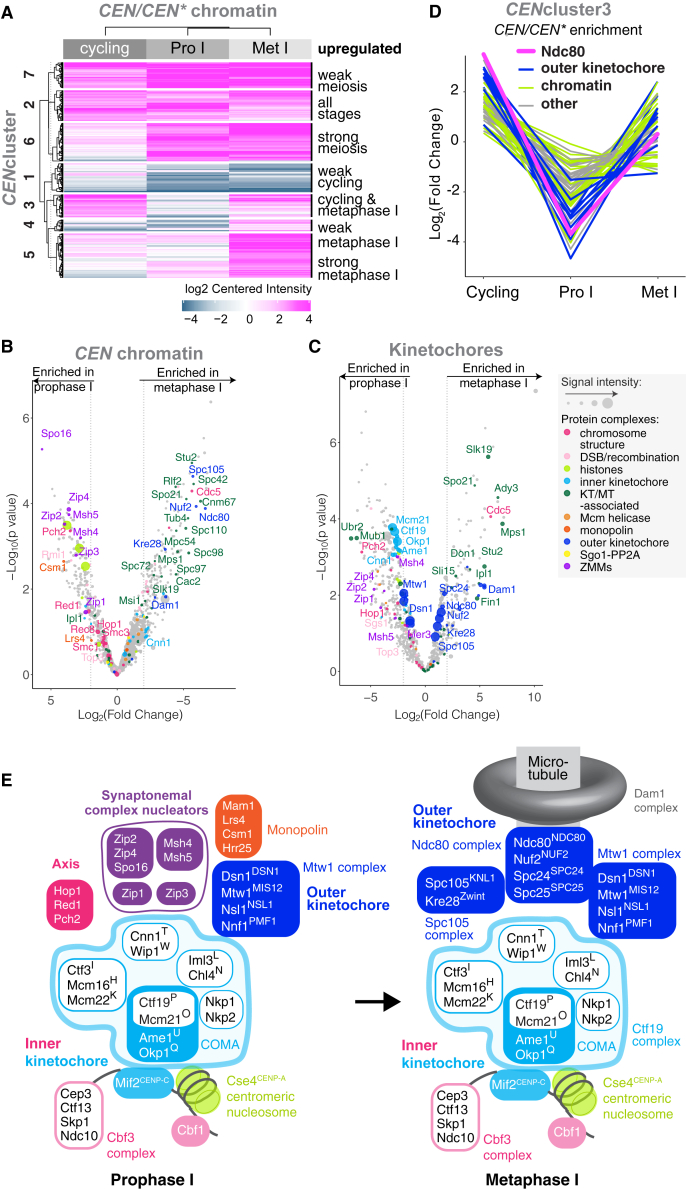
Changes in the Centromeric and Kinetochore Proteomes between Meiotic Prophase I and Metaphase I(A) CEN chromatin exhibits distinct composition signatures at different stages. The CEN chromatin/CEN∗ chromatin enrichment values for each of cycling, prophase I-arrested, and metaphase I-arrested conditions were clustered (k-means) to identify groups of proteins with similar behavior. A cut-off of Log2(fold change) > 2 and p < 0.05 was used.(B and C) Composition of CEN chromatin (B) or kinetochore particles (C) isolated from prophase I and metaphase I is strikingly different. Volcano plot presenting the LFQMS-identified proteins co-purifying with CEN plasmids (B) or Dsn1-6His-3FLAG (C) immunopurified from cells arrested in prophase I (ndt80Δ, B; inducible-NDT80, C) and metaphase I (pCLB2-CDC20). Log2(fold change) between conditions is shown with corresponding p values (STAR Methods). Dashed line indicates |Log2(fold change)| = 2.(D) Several proteins exhibit Ndc80NDC80-like depletion from centromeres specifically during meiotic prophase. Mean-centered Log2(fold change) from CENcluster3 is plotted to show abundance of individual proteins in the indicated stages.(E) Schematic illustrating changes in the kinetochore association of some key complexes between meiotic prophase I and metaphase I observable by proteomics.See also Figures S1 and S2 and Tables S2 and S3.